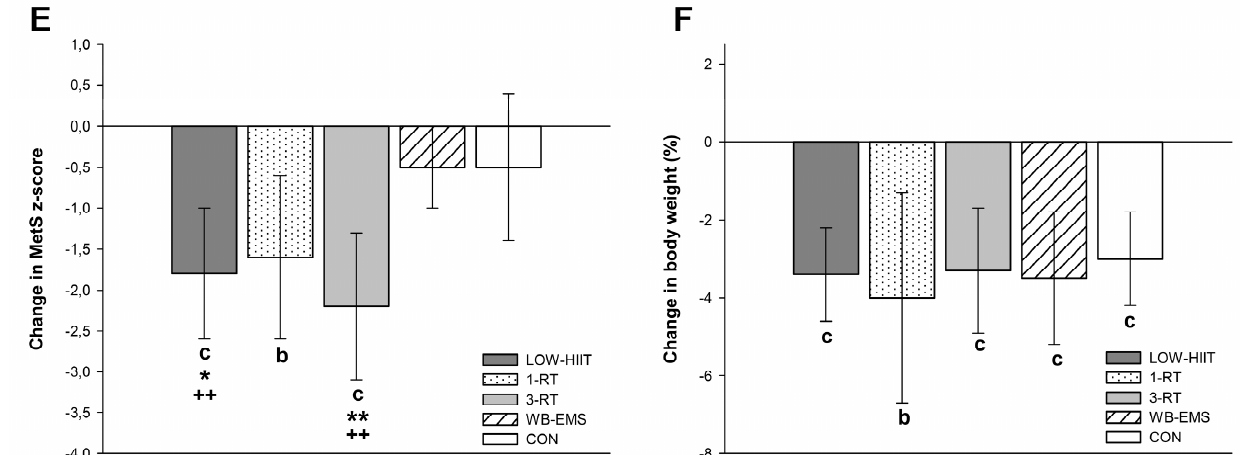
Figure 2. Changes in serum concentrations of C-reactive protein ( A ), high-sensitivity C-reactive protein ( B ), interleukin-6 ( C ), lipopolysaccharide-binding protein ( D ), and changes in MetS z-score ( E ) and body weight ( F ). a ( p < 0.05), b ( p < 0.01), c ( p < 0.001): significant difference versus pre-intervention; * ( p < 0.05), ** ( p < 0.01): significant difference versus CON; ++ ( p < 0.01): significant difference versus WB-EMS.